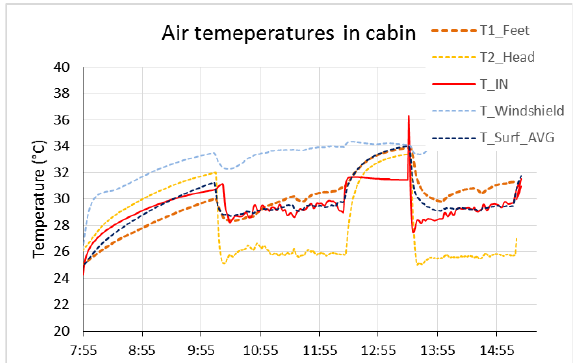
Fig. 5. Summer test for subject N.1-4. VTSCC prediction.